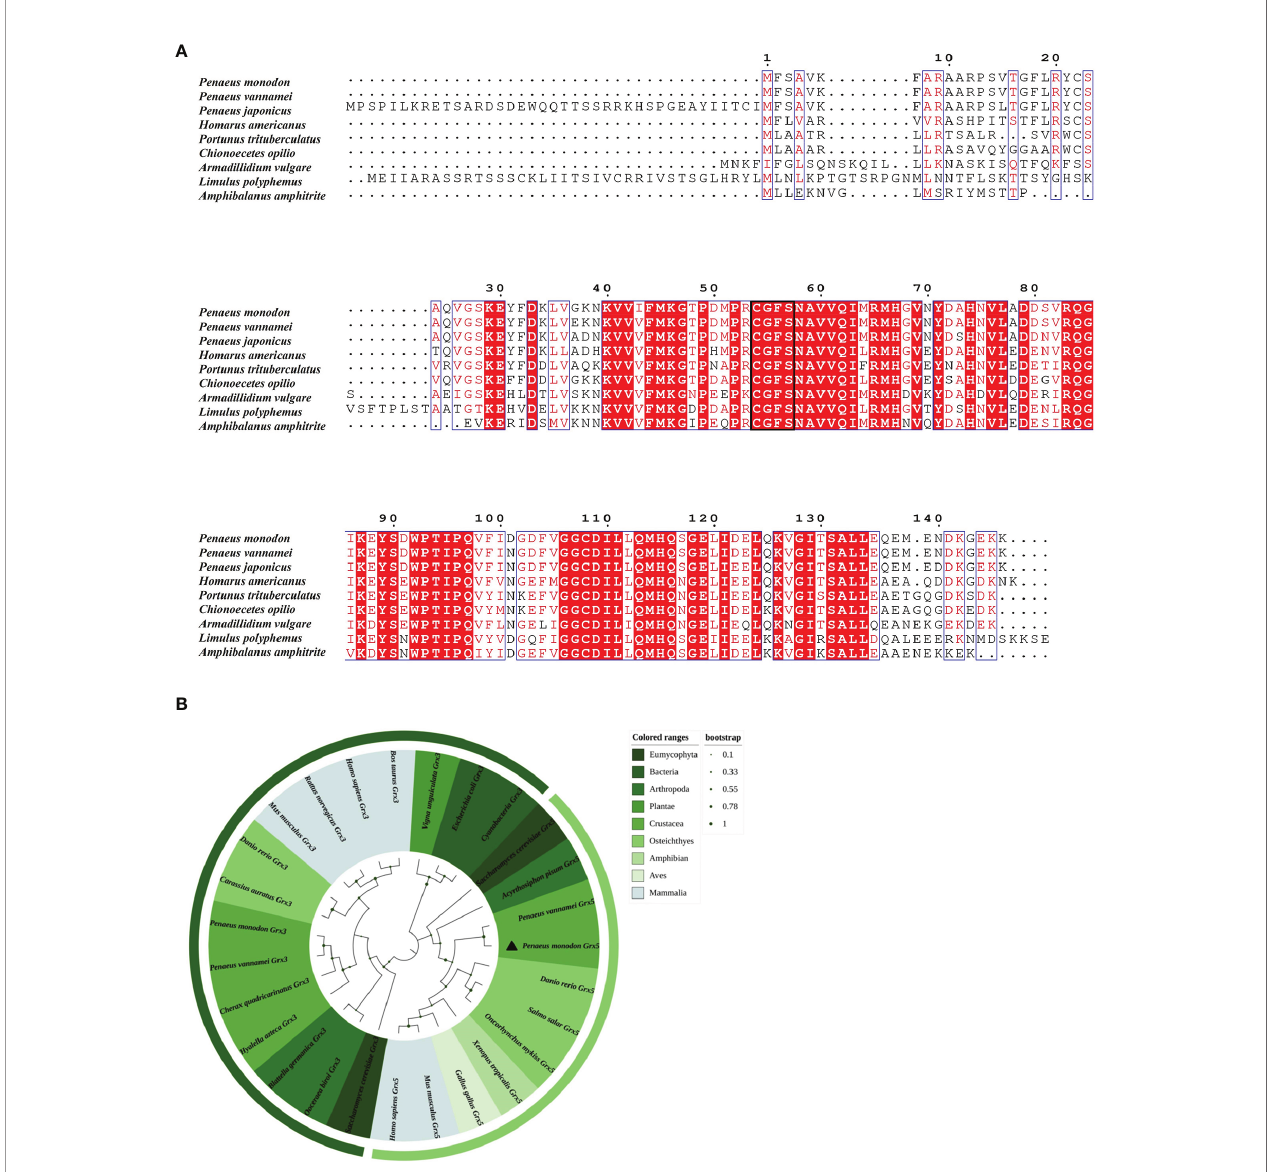
FIGURE 2 | (A) Multiple sequence alignment of Grx5 from nine arthropod species. Red regions indicate conserved amino acid residues. Red letters indicate similar residues. Conserved active sites C-G-F-S are highlighted in a black box. The results of the amino acid sequence counts are shown at the top of each row. (B) A phylogenetic tree of mono-mercapto Grxs of various species based on amino acid sequences. Bootstrap support values corresponding to each branch are indicated by the dark green dots. The dimensions and corresponding values of the dark green dots are indicated on the right side of the picture. The corresponding species in different colors are shown on the right side of the picture. The dark green outermost arcs indicate the branches of the Grx3 protein. The light green outermost arc indicates the branch of the Grx5 protein. PmGrx5 is marked with a triangle. The scienti fi c names of all the above species and their NCBI sequence numbers are shown below: Amphibalanus amphitrite (KAF0307822.1), Acyrthosiphon pisum (AK341132.1), Armadillidium vulgare (RXG69803.1), Blattella germanica (PSN36174.1), Bos taurus (NP_001030273.1), Carassius auratus (XP_026078075.1), Chionoecetes opilio (KAG0717517.1), Cherax quadricarinatus (AEL23128.1), Cyanobacteria (WP_190627512.1), Danio rerio (NP_001005950.1), Danio rerio (BC059659.1), Escherichia coli (SYX47894.1), Gallus gallus (AJ720261.1), Homarus americanus (XP_042230596.1), Hyalella azteca (KAA0195653.1), Homo sapiens (AAH05289.1), Homo sapiens (AB223038.1), Limulus polyphemus (XP_013786644.1), Mus musculus (NP_075629.2), Mus musculus (AK013761.1), Ooceraea biroi (EZA62809.1), Oncorhynchus mykiss (BT073697.1), Penaeus monodon (MZ827442), Penaeus japonicus (XP_042868605.1), Portunus trituberculatus (MPC08028.1), Penaeus vannamei (XP_027209771.1), Penaeus vannamei (XP_027214062.1), Penaeus vannamei (XM_027358261.1), Rattus norvegicus (AAH86381.1), Saccharomyces cerevisiae (GFP69319.1), Saccharomyces cerevisiae (NM_001183873.1), Salmo salar (BT048738.1), Vigna unguiculata (QCE13504.1), and Xenopus tropicalis